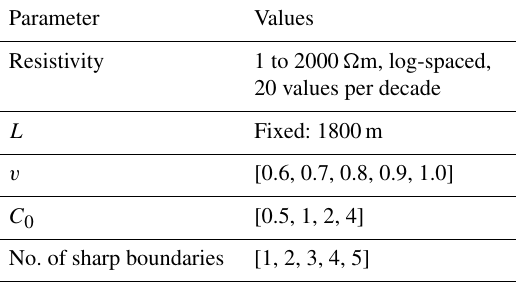
Table 2. Parameters used in all combinations to generate the initial von Kármán resistivity